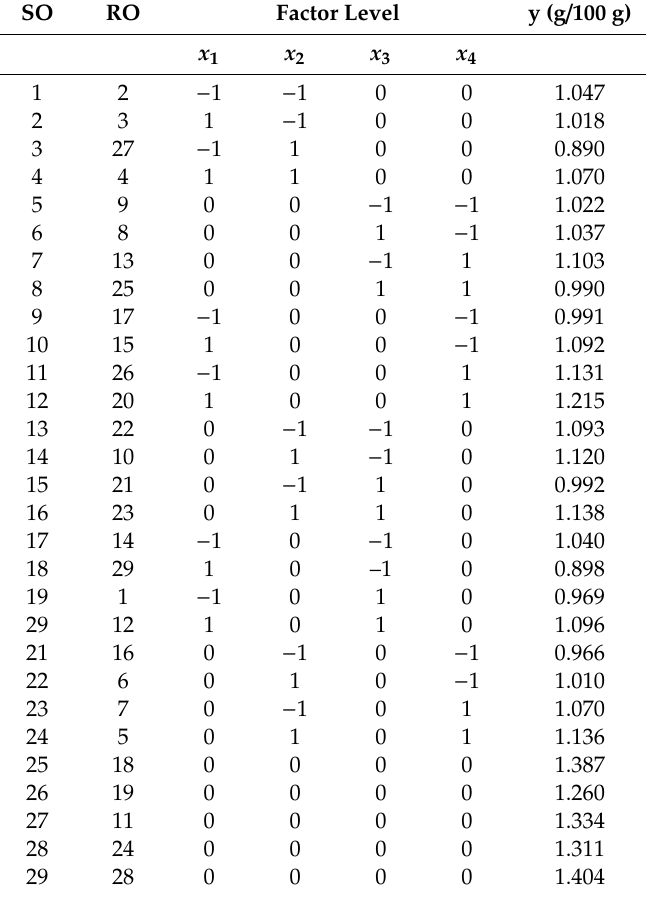
Table 2. Experimental design layout and observed response (y). SO and RO are the standard and the run order of